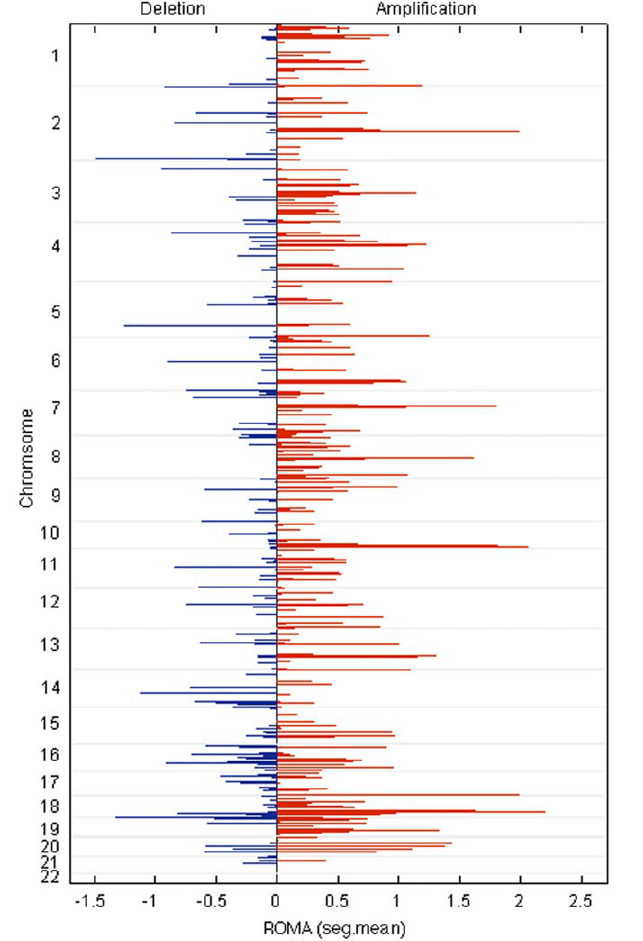
Figure 2. Amplification and deletion breakpoint variability among ROMA segments. Breakpoint positions of copy number variability (deletions depicted in blue, amplifications depicted in red) in 22 chromosomes are shown as determined from ROMA generated segmentation data. The initial altering deletion or amplification genomic position is depicted from all 42 ovarian tumor cancer samples.